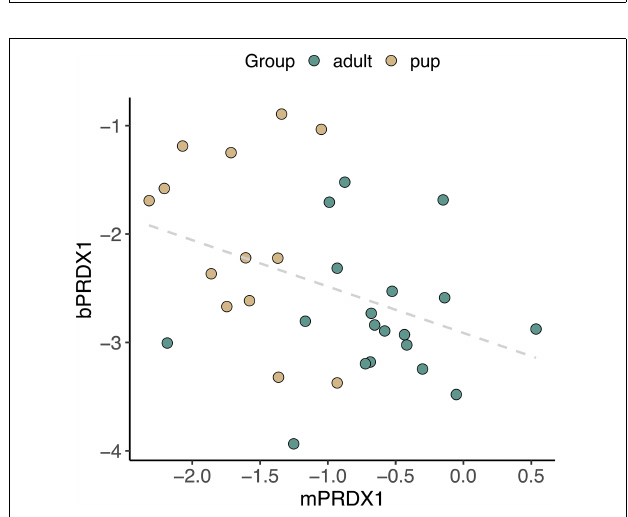
FIGURE 9 | Expression of the gene encoding antioxidant enzyme PRDX1 in NES muscle (m PRDX1 ) and blood (b PRDX1 ) was negatively associated ( r S = –0.40, p =